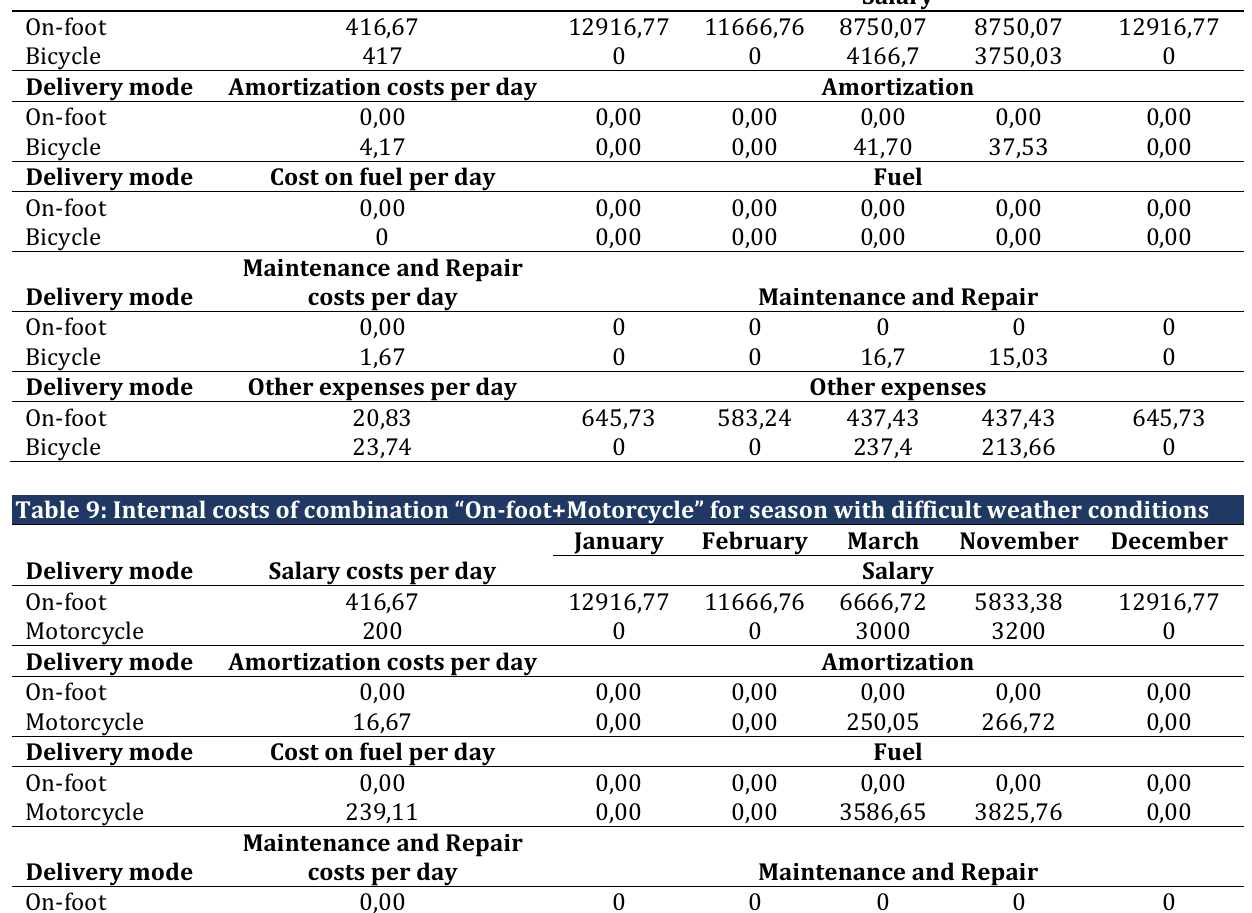
Table 8: Internal costs of combination “On-foot+Bicycle” for season with difficult weather conditions Delivery mode